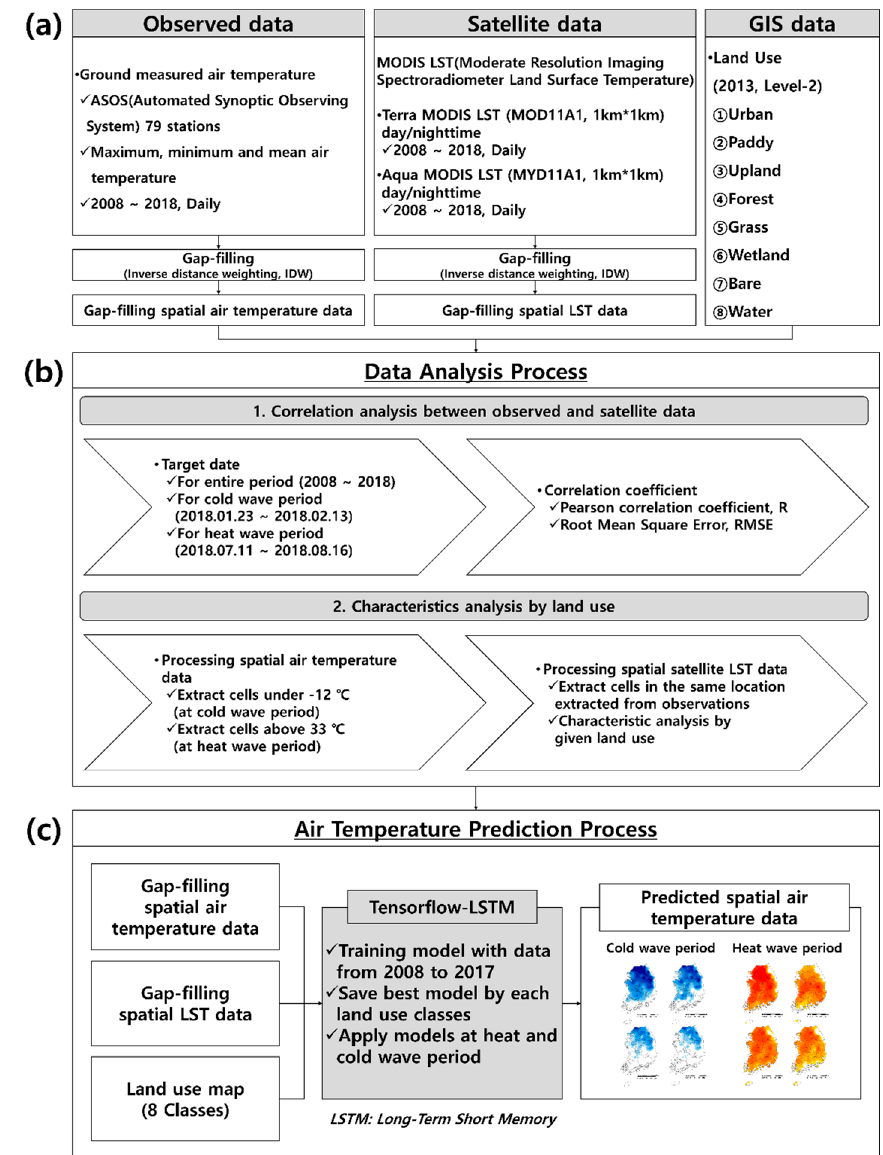
Figure 1. Flowchart of the study: ( a ) a brief description of datasets, ( b ) data analysis (correlation and characteristics) process, and ( c ) air temperature prediction.